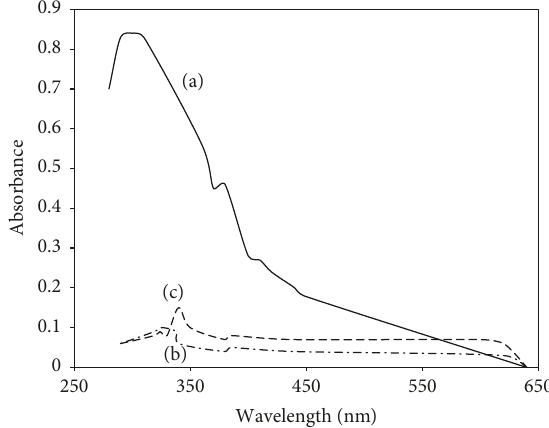
Figure 9: Thermal gravimetric analysis of PVC grafted by various Figure 10: UV spectra of degraded (a) parent PVC, (b) PVC itaconimide derivatives as compared to PVC. % of graft for samples grafted by N -(4-BrPh)IM, and (c) PVC modified by N -(4-BrPh)IM 2–2.5%. samples, dissolved in THF (concentration 0.02g · l − 1 ), at 180 ° C for 2 hours in Table 5: Initial decomposition ( T 0 ) and total weight loss per- centage, at 500 ° C, of grafted and modified PVC as compared to PVC, under the nitrogen atmosphere.